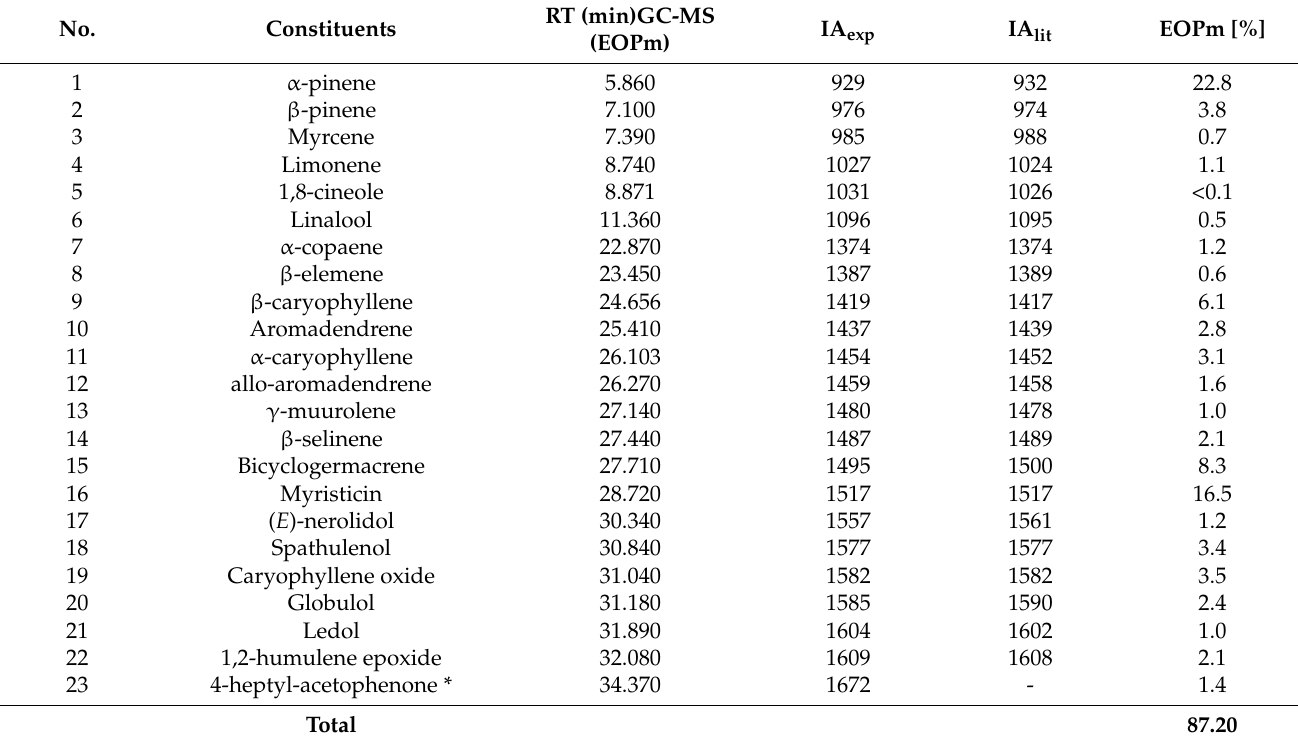
Table 1. GC-MS analysis of the chemical composition of essential oil Piper mosenii